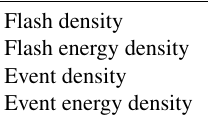
Table B4. Variables from the GOES-16 GLM instrument adopted in this